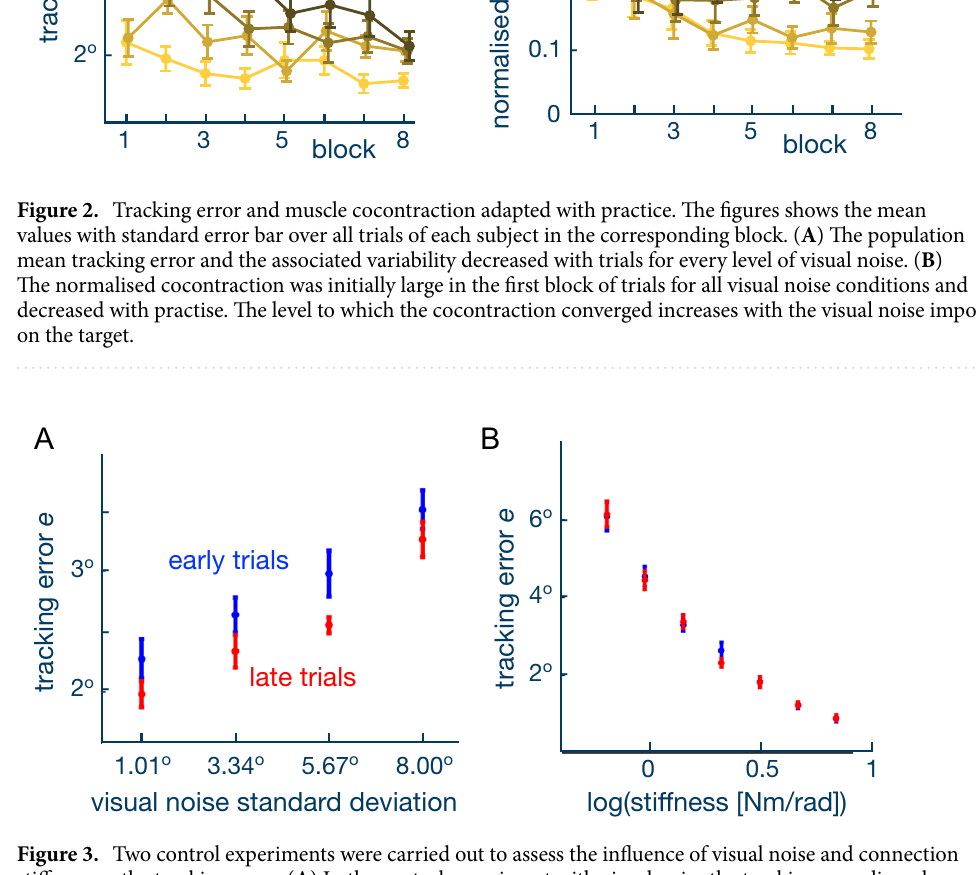
Figure 3. Two control experiments were carried out to assess the influence of visual noise and connection stiffness on the tracking error. ( A ) In the control experiment with visual noise the tracking error linearly grows with visual noise, and decreases across all noise levels with practise. ( B ) In the experiment with haptic feedback only, the tracking error decreases with the log of the connection stiffness (validated with linear mixed-effect analysis: p < 1e − 09 ). This relationship does not change with